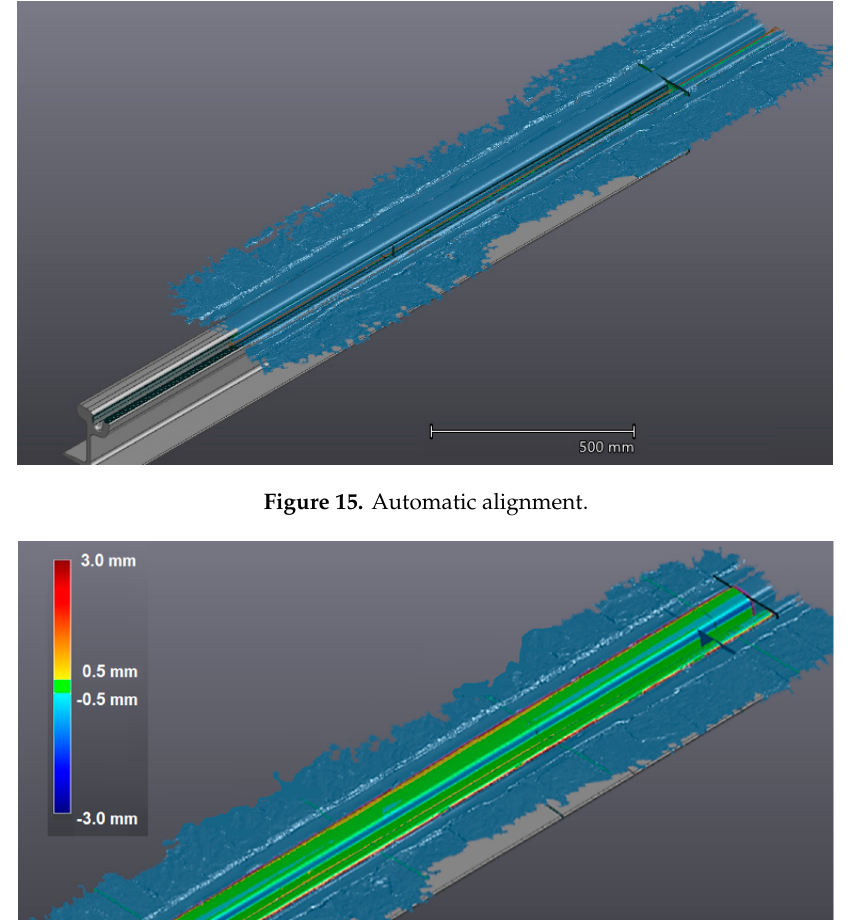
Figure 16. Color map of deviations.